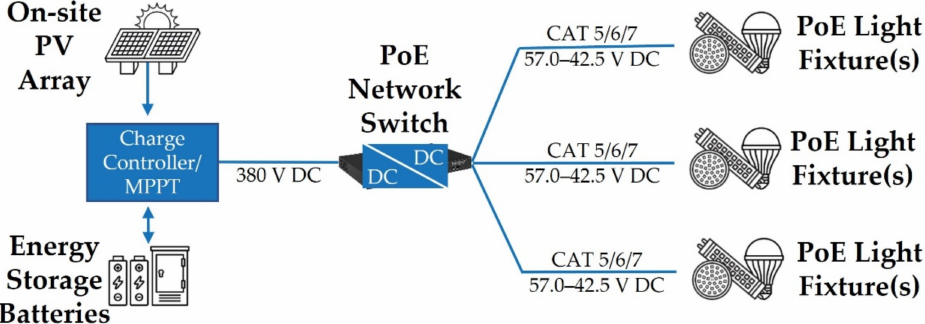
Figure 5. DC-powered PoE lighting